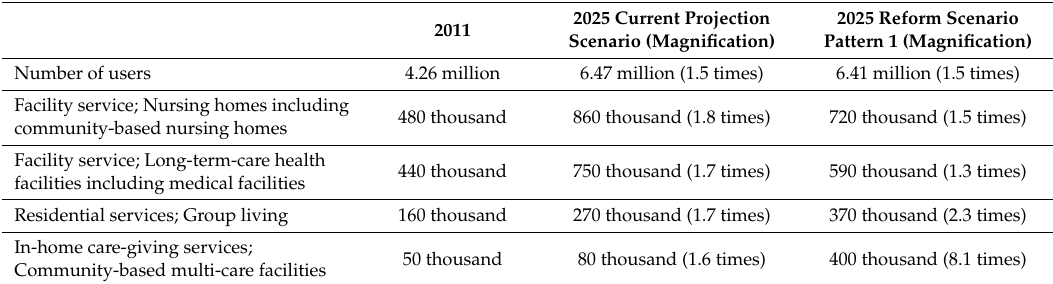
Table 3. Prospective number of users of elderly care facilities from “Issues related to a review of the system of the elderly care in regard to social insurance and tax integration reform”